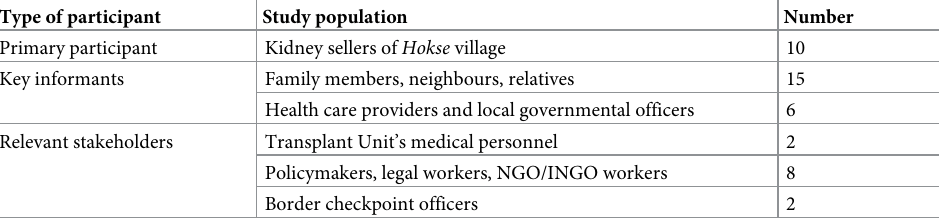
Table 1. Details of the study